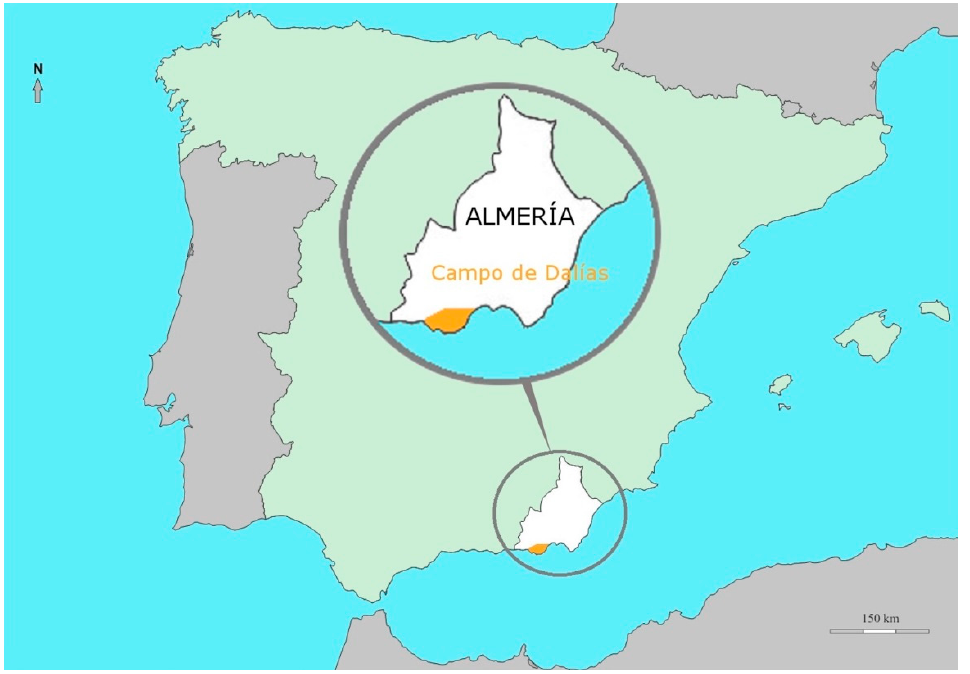
Figure 1. Map of Spain showing the location of the research area.